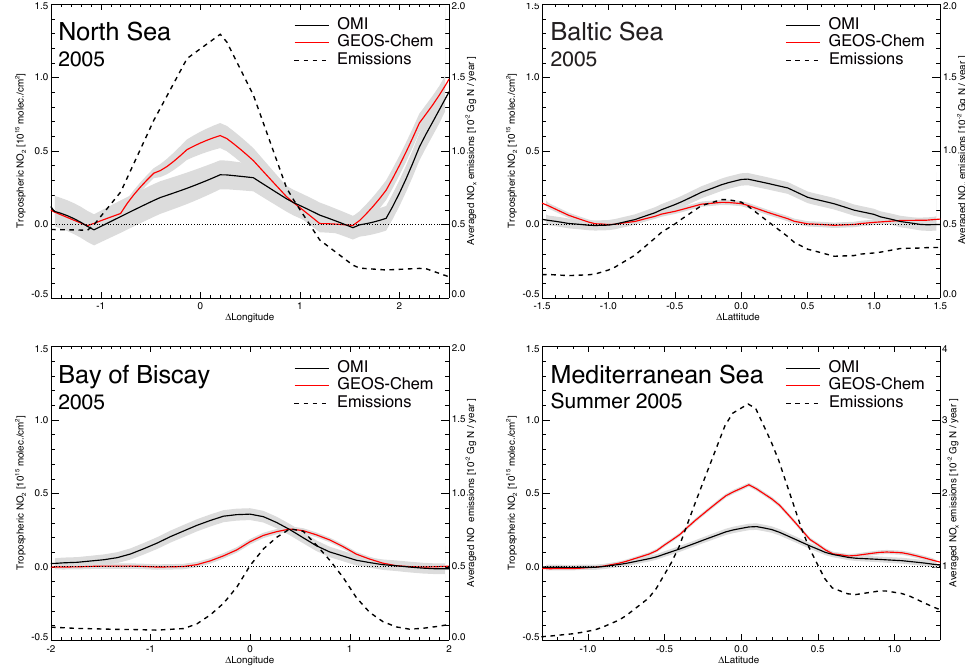
Fig. 8. Along-ship-track averages of tropospheric NO 2 columns over the areas in Fig. 6c for observed columns by OMI (black line), and simulated columns by GEOS-Chem (red line). The area was averaged over longitude for the Baltic Sea (between 16 and 19.33 ◦ E, upper right) and the Mediterranean Sea (21.33 to 24.67 ◦ E, bottom right), and over latitude for the North Sea (54.5 to 56.5 ◦ N, upper left) and the Bay of Biscay (44.5 to 46.5 ◦ N, lower left). Emissions averaged along the ship track are represented by the dashed line. A linear background fit was subtracted from the averages, and grey shading represents the sample standard